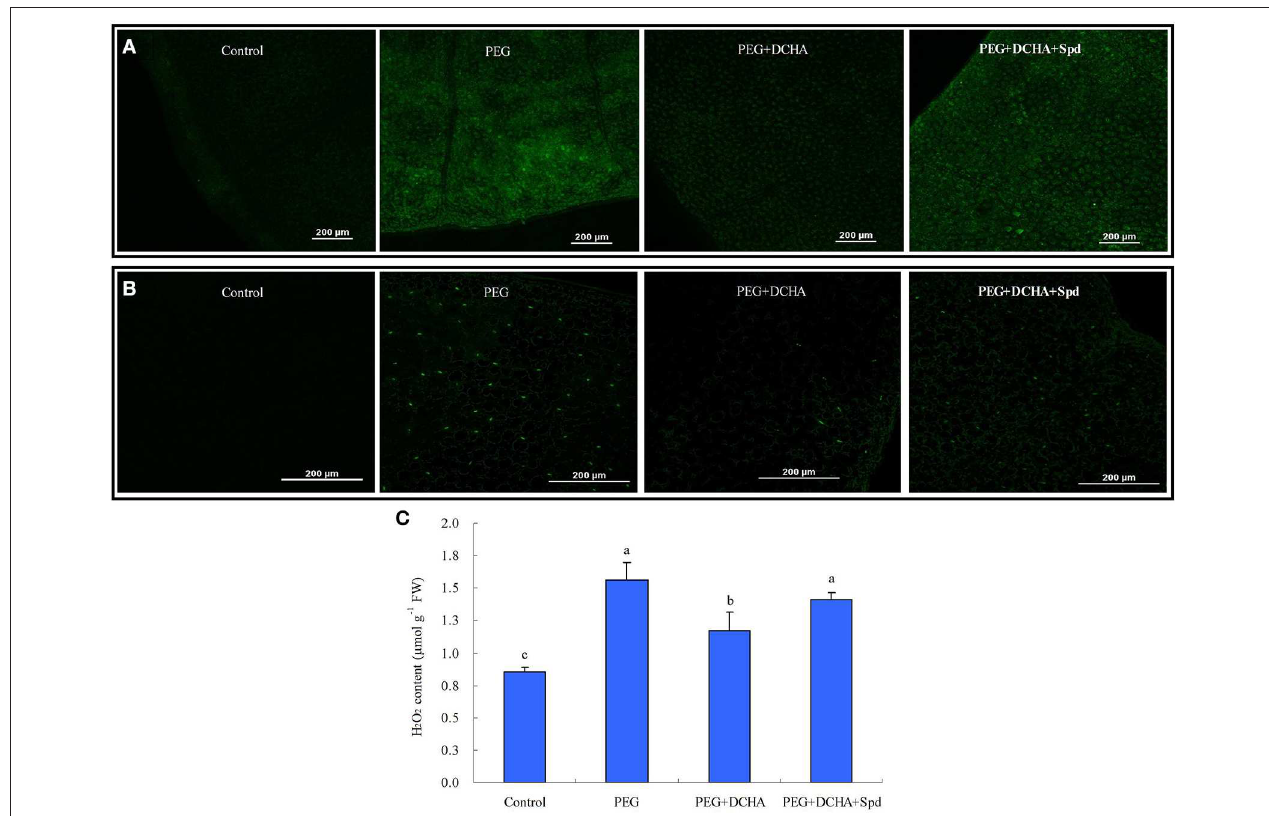
FIGURE 6 | Effects of polyamine (PA) on PEG-induced cytosolic free Ca 2 + (A) and H 2 O 2 production (B,C). The detached leaves of white clover were pre-treated with distilled water for 1h to eliminate wound stress and then treated for 45min as follows: 1, distilled water (control); 2, 15% PEG; 3, 15% PEG + 100 µ M dicyclohexylamine (DCHA); 4, 15% PEG + 100 µ M DCHA + 20 µ M Spd and followed by incubation with Ca 2 + -sensitive fluorescent probe Fluo-3-AM or H